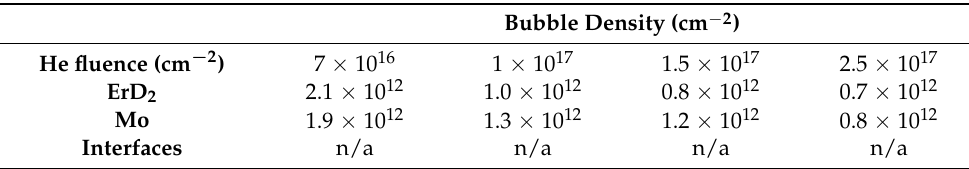
Table 4. He bubble density at each ex-situ He implantation fluence.